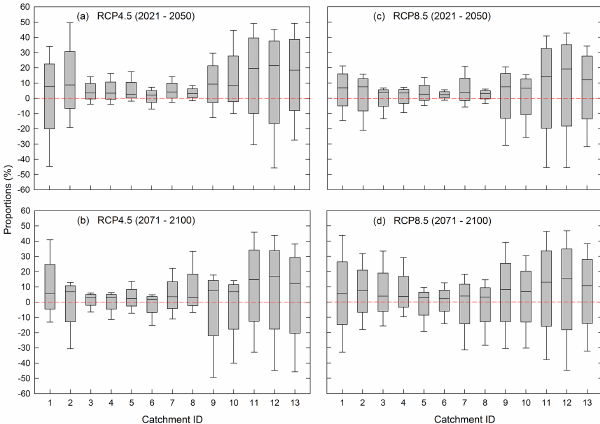
Figure 9. Box plots of contributions of LAI to the climate change effect on mean annual runoff for future (2021–2050, 2071–2100) climate forcings under RCP4.5 (a, b) and RCP8.5 (c, d) emission scenarios from each of the 38 CMIP5 runs as compared to the his- torical (1981–2010) period. The LAI effect is normalized by the ef- fect of precipitation and temperature with unchanged LAI (i.e., CC effect) and expressed as a percentage. The lower boundary of the box indicates the 25th percentile, a line within the box marks the median, the upper boundary of the box indicates the 75th percentile and the whiskers are delimited by the maximum and